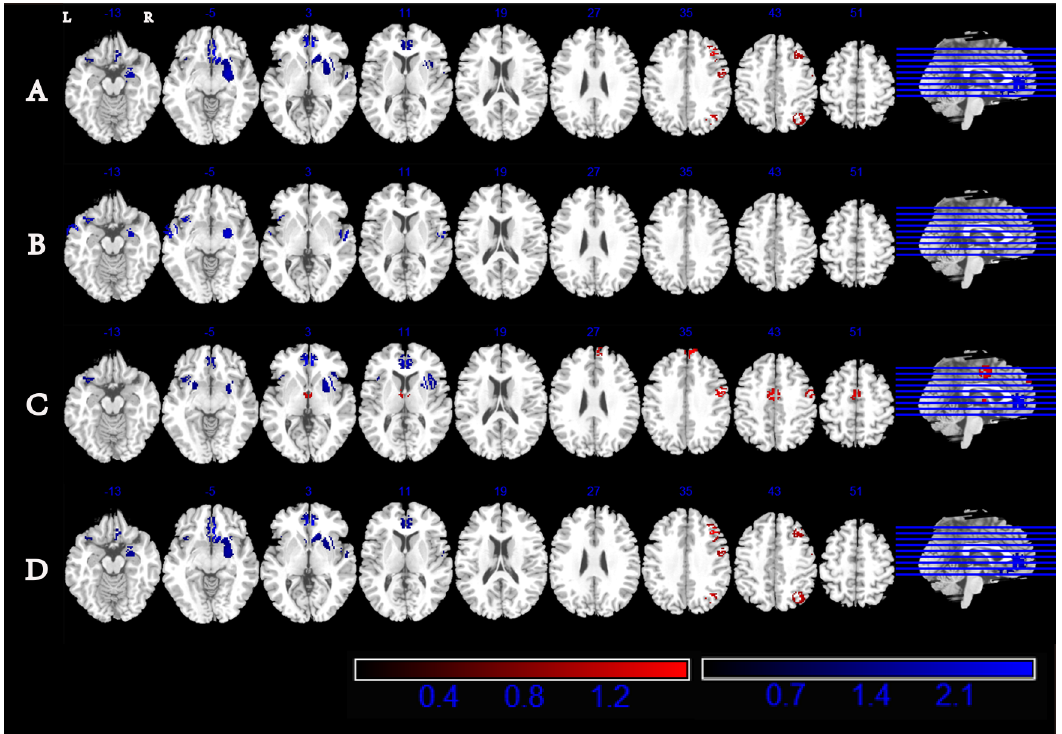
Figure 1. SDM map investigating changes of GMV in anxiety patients comorbid depression (A), anxiety patients without comorbid depression(B), drug-naı¨ve patients(C) and adult patients(D) with axial sections. All coordinates are in the Talairach space and clusters are displayed using the standard ES-SDM thresholds (uncorrected P , 0.005, extent threshold of clusters . 10 voxels). Areas with increased gray matter relative to controls are displayed in red, and areas with decreased gray matter are displayed in blue. L, left; R, right.